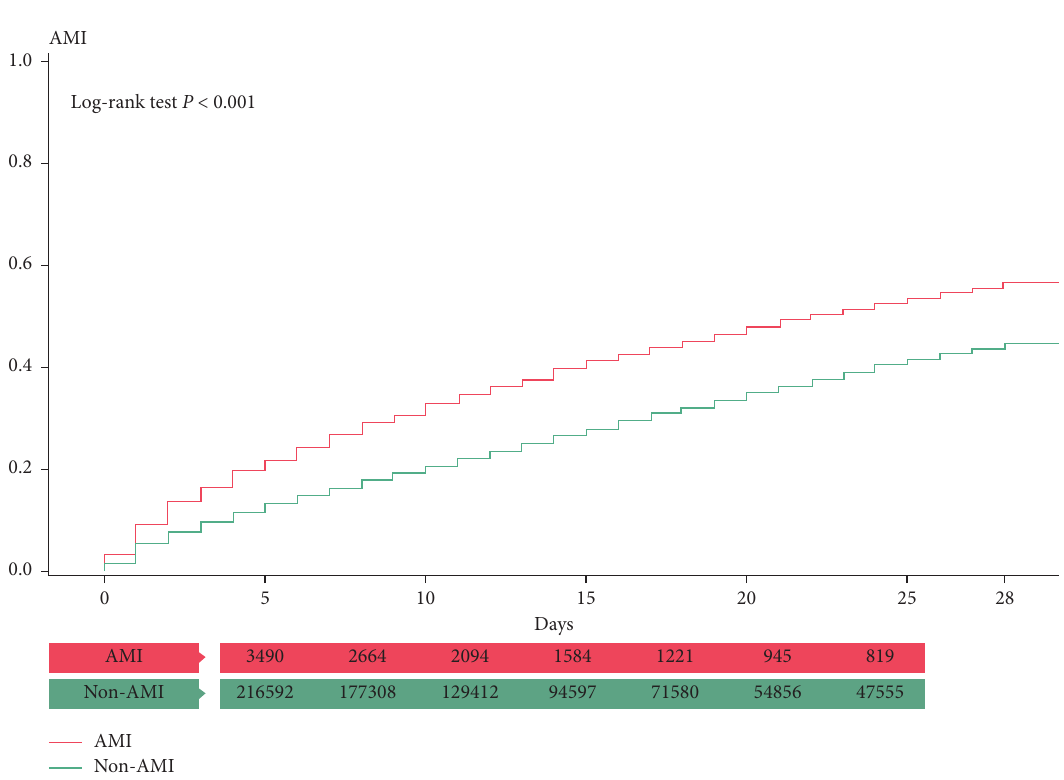
Figure 1: Kaplan–Meier analysis of cumulative hospital mortality in sepsis patients with and without AMI. The differences were evaluated by the log-rank test.